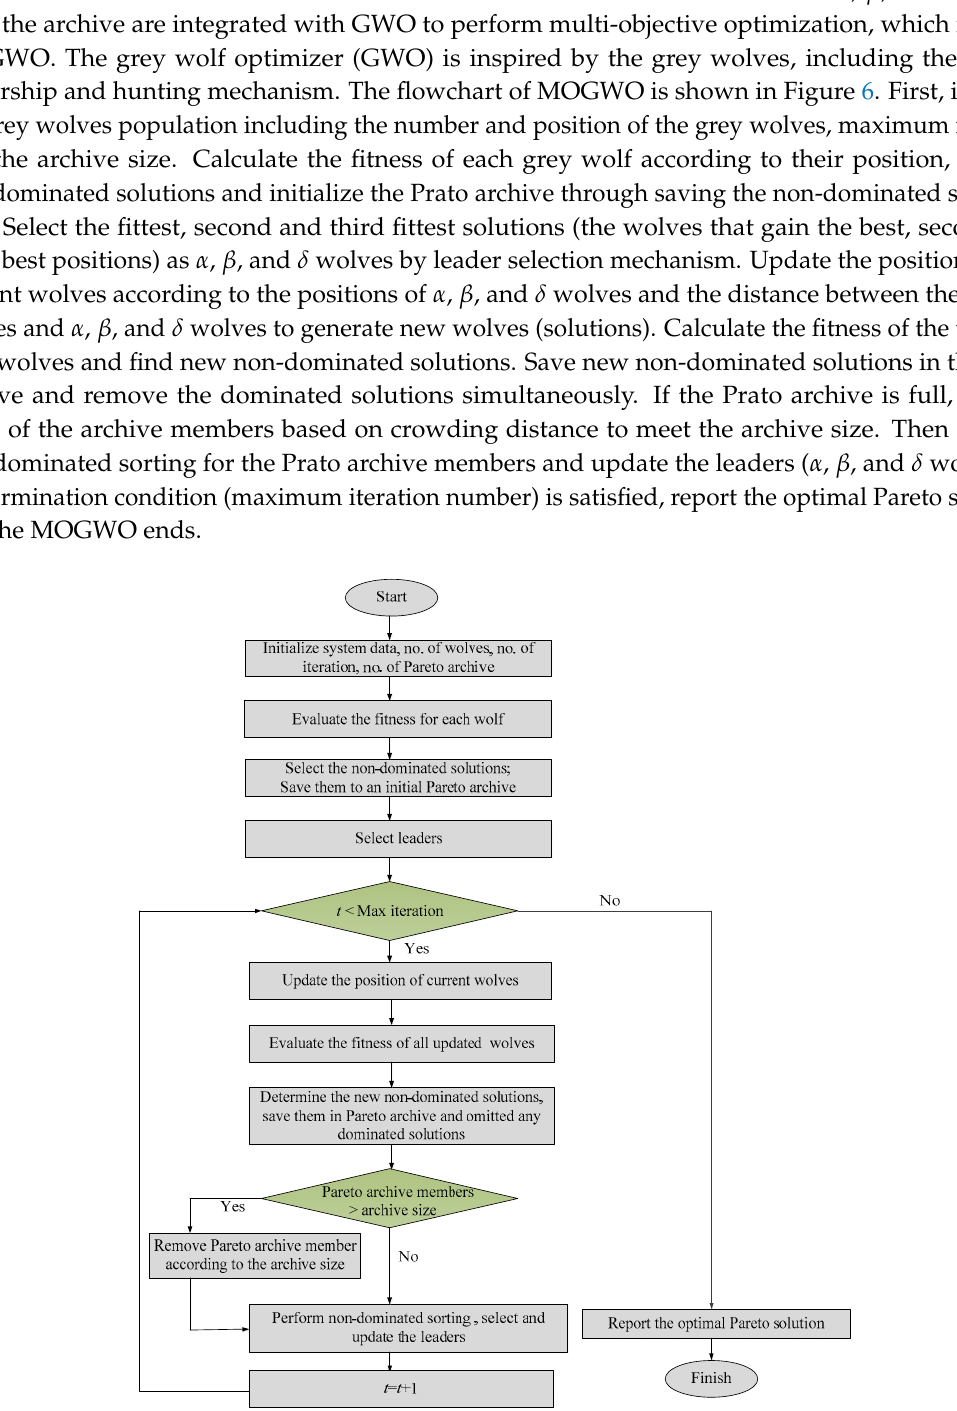
Figure 6. Flowchart of the multi-objective grey wolf optimizer (MOGWO) algorithm.